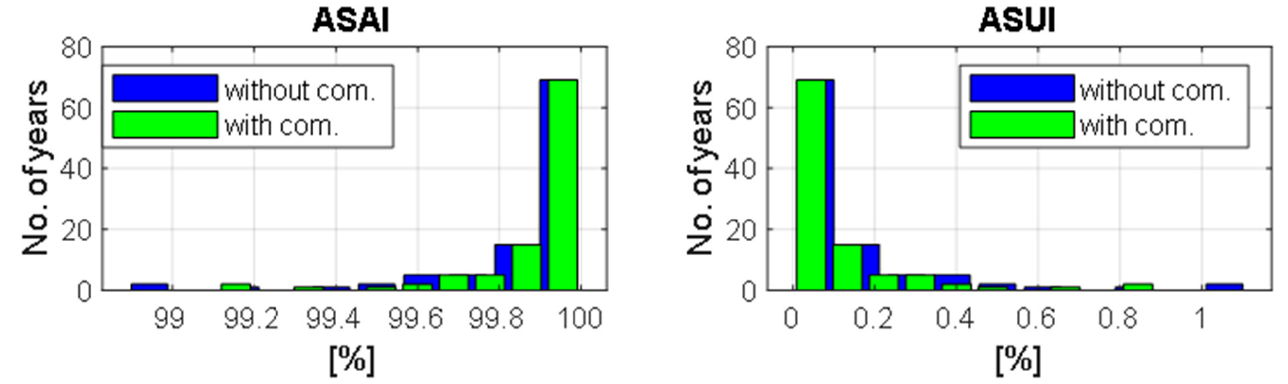
Figure 7. Index distributions obtained from the simulation of an electric power system with and without a communications